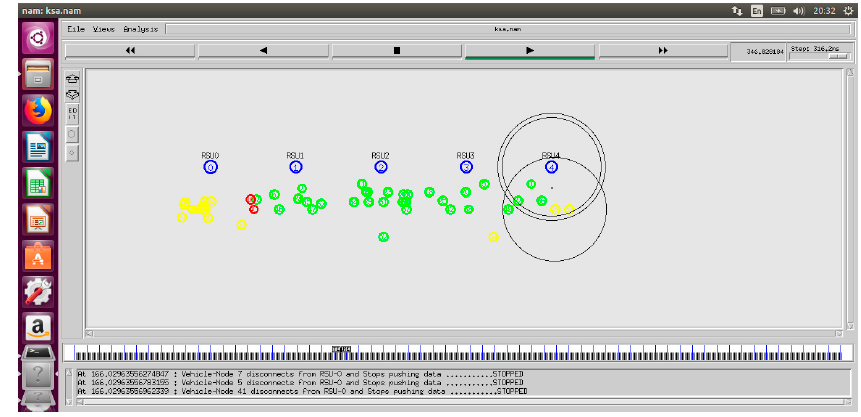
Figure 10. TARS simulation by using NS-2.35.